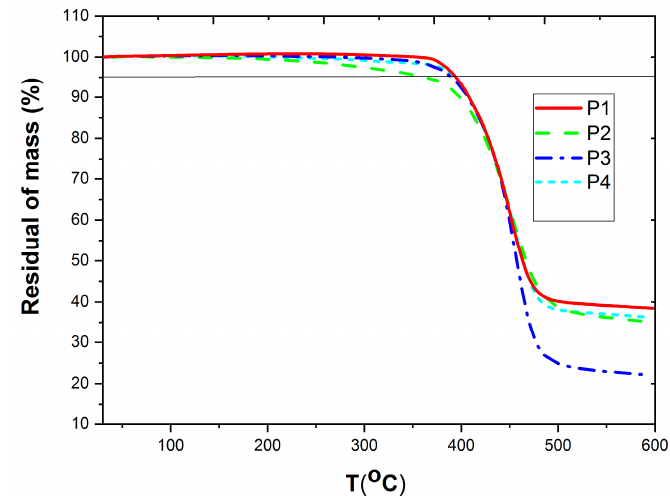
Figure 1. Thermogravimetric analysis (TGA) curves of polymers under N 2 at a heating rate of 10 °C/min.